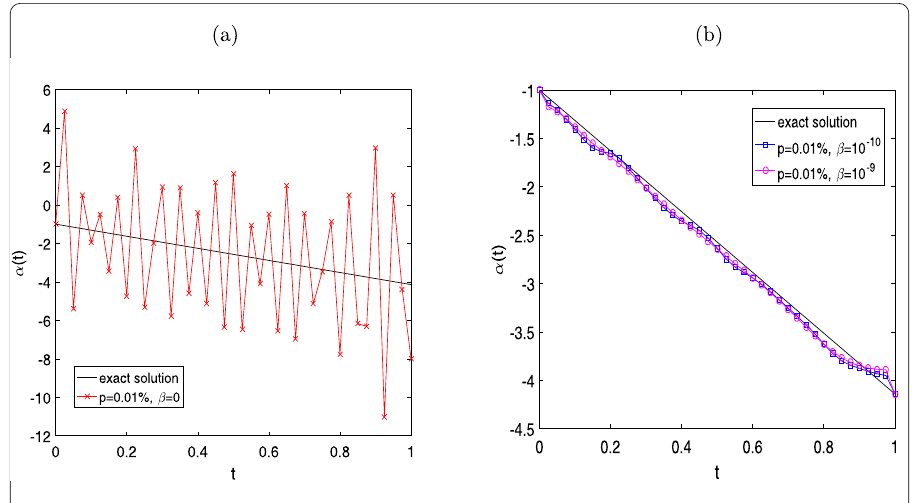
Figure 4 The analytical (36) and approximate α ( t ) with p = 0.01% for: ( a ) β = 0 and ( b ) β = 10 –10 and 10 –9 for Test 1